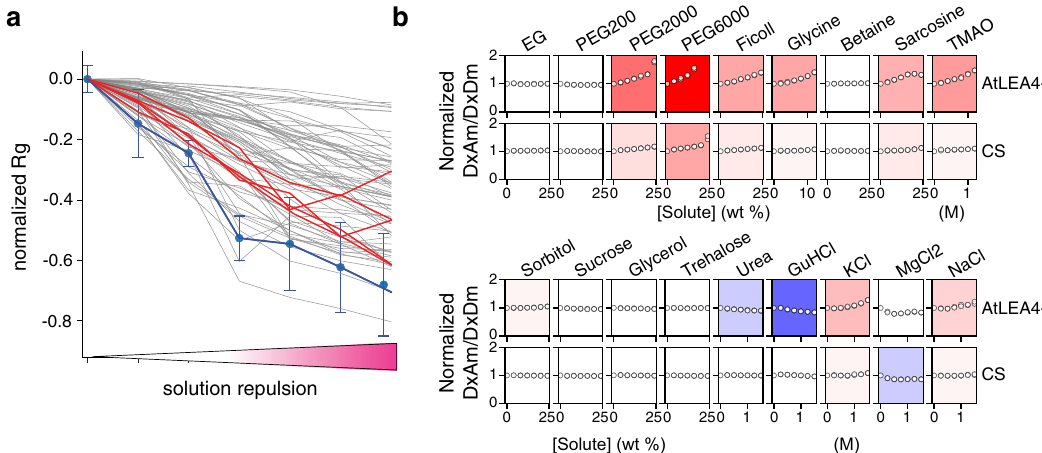
Fig. 2 AtLEA4-5 is highly sensitive to the chemical composition of the solution. a Computational solution space scan of the normalized radius of gyration (Rg) of AtLEA4-5 (blue), fi ve different scrambled sequences shown in Fig. 1e, f (red), and 70 different naturally occurring IDRs (gray) under different solution repulsion levels (low to high solution repulsion of the protein backbone). Mean ± SD from n = 5 independent simulations. For clarity, only AtLEA4- 5 (blue) SD is shown. SD for the other proteins are provided in the Source Data fi le. b Experimental solution space scan of AtLEA4-5 and CS. Open circles show the normalized FRET ratio (DxAm/DxDm) for the indicated concentration of each solute, with two points (that often overlap) for each concentration taken from separate repeats, highlighting the reproducibility of the data. Background color intensity represents sensitivity to the addition of solute. Stronger colors indicate stronger sensitivity. Red: compaction; blue: expansion; white: no change. Solution concentrations are given in weight percent (0 – 25 or 0 – 12 wt%) or molar (0 – 1.5 M). Source data are provided as a Source Data fi